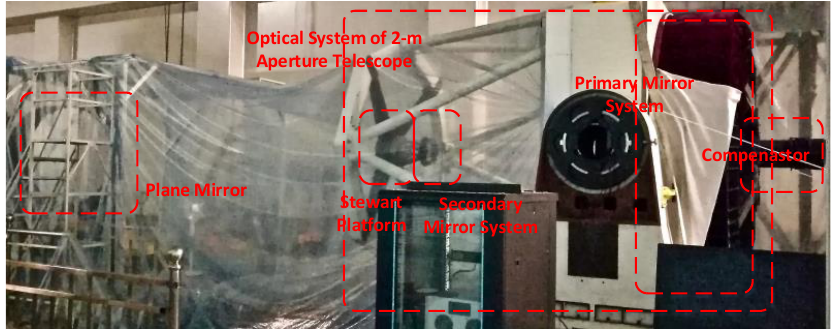
Figure 15. Experimental diagram showing the detecting primary and secondary mirror (SM) system.